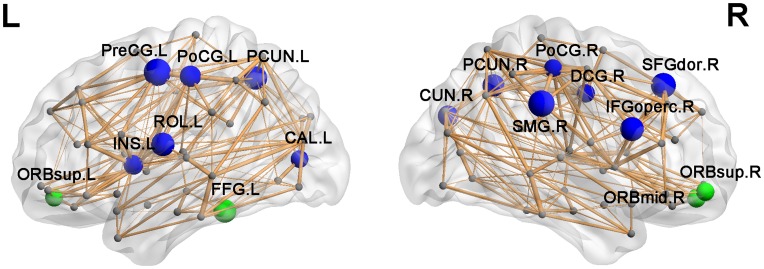
The brain regions with significant group differences in nodal efficiency between control and NMO groups at p<0.05 (uncorrected).The node sizes indicate the significance of between-group differences in the regional efficiency. The network shown here was constructed by averaging the WM connection matrices of all healthy controls and thresholded with the sparsity of 10%. The nodal regions are located according to their centroid stereotaxic coordinates. Nodes in blue showed the regions have reduced efficiency in NMO patients versus controls. Nodes in green showed the regions have increased efficiency in NMO patients versus controls. For the abbreviations of nodes, see Table 2.